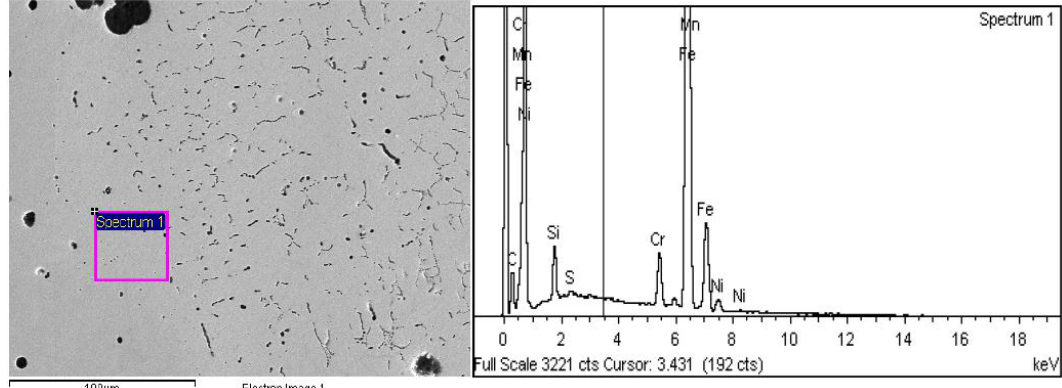
Figure 11. SEM and micrograph of the weld interface with filler applied using a 97% Ni electrode without subsequent heat treatment. Note the low Cr content.